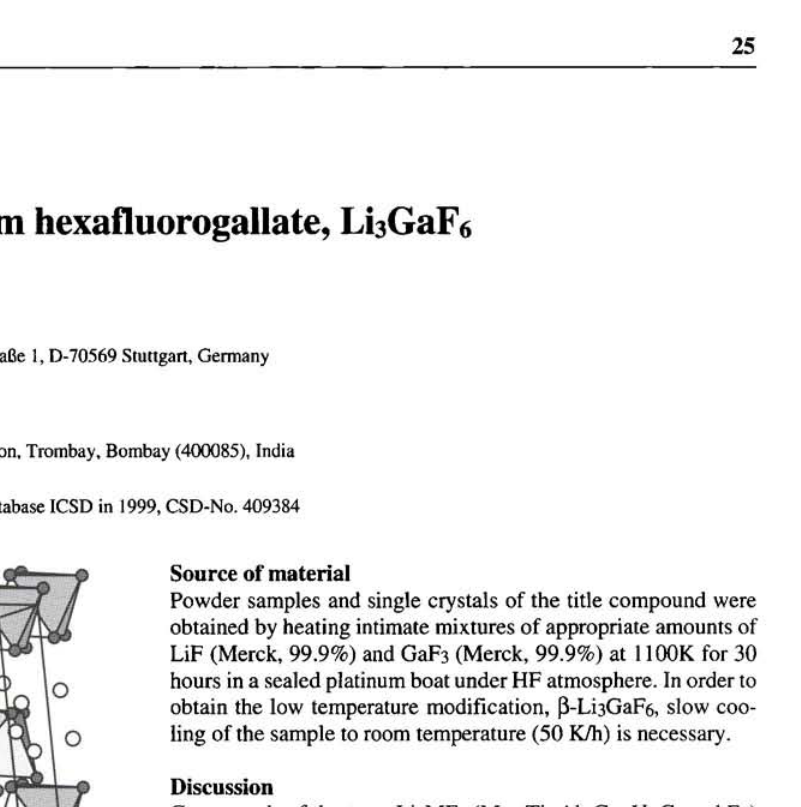
Table 1. Data collection and handling. Crystal: